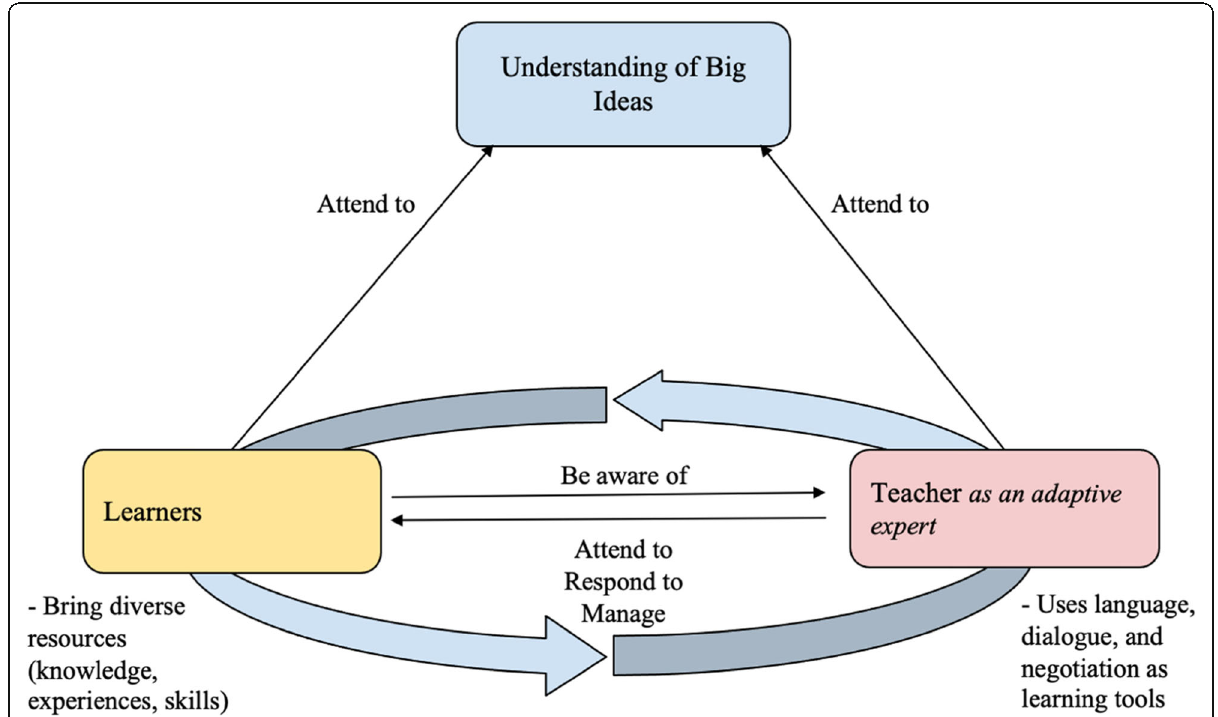
Fig. 1 Model of Elementary Science Teacher